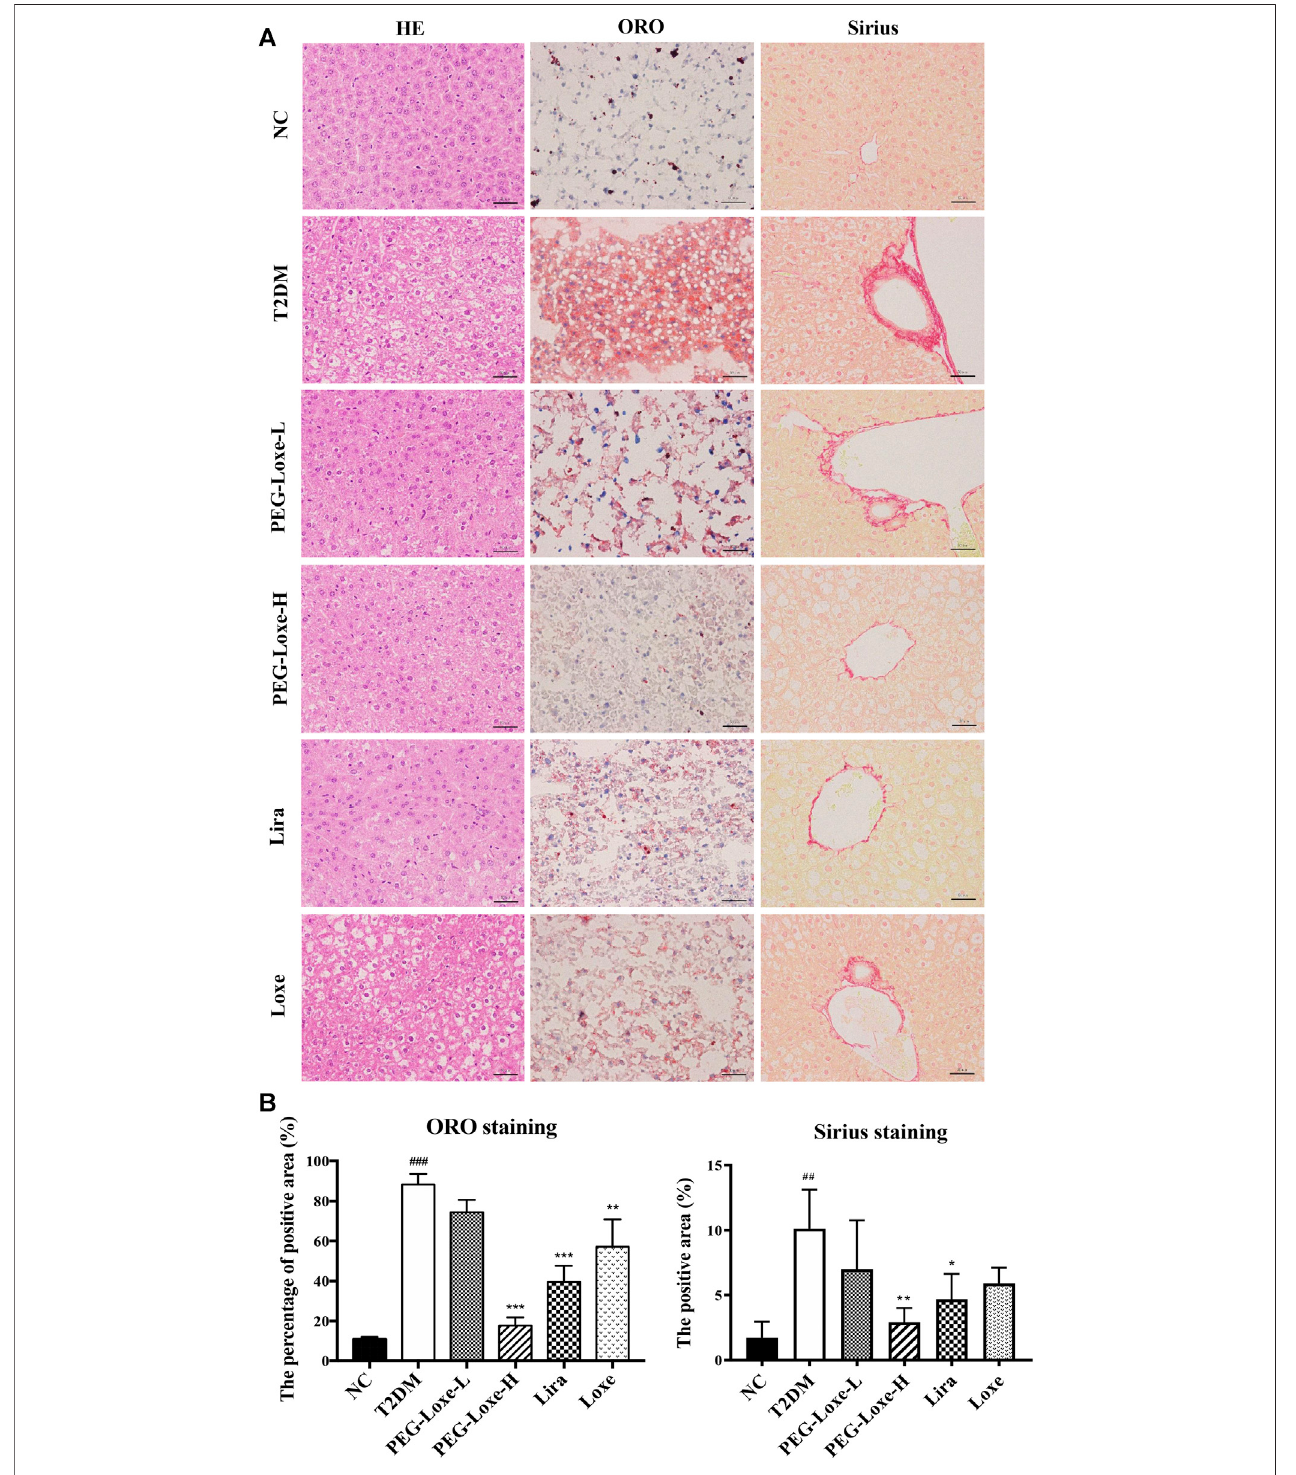
FIGURE 2 | Effects of polyethylene glycol loxenatide (PEG-Loxe) on the histopathological changes in the liver of db/db mice (A) Representative images of the hematoxylin and eosin (H&E), oil red O (ORO), and Sirius staining of liver tissues (400 × ) (B) Quantitative analysis of liver injury using ORO and Sirius staining. Data are presented as the mean ± SD; n (cid:2) 3; ## p < 0.01 and ### p < 0.001 compared to the normal control group; * p < 0.05, ** p < 0.01, and *** p < 0.001 compared to the T2DM group.